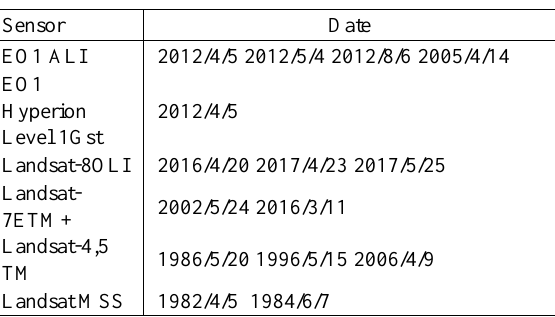
Figure 2 shows the image characteristics of coastal beach in the same location in different years and different sensor remote sensing images. These spectral curves all exhibit a